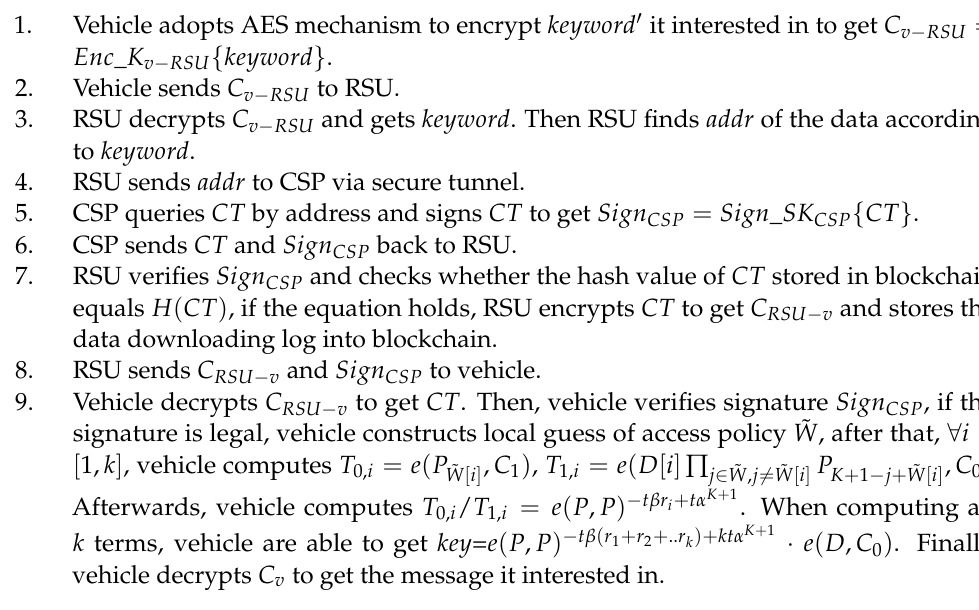
Figure 5. Data downloading